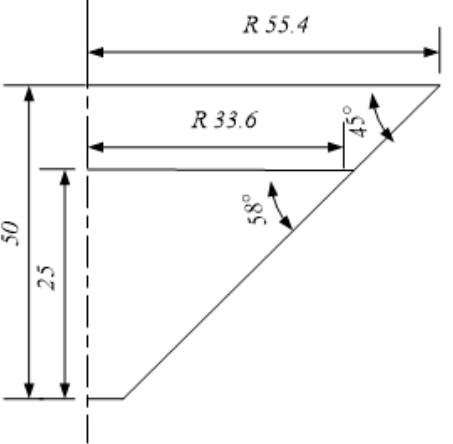
Figure 5. Theoretical models of the test parts and actual parts.